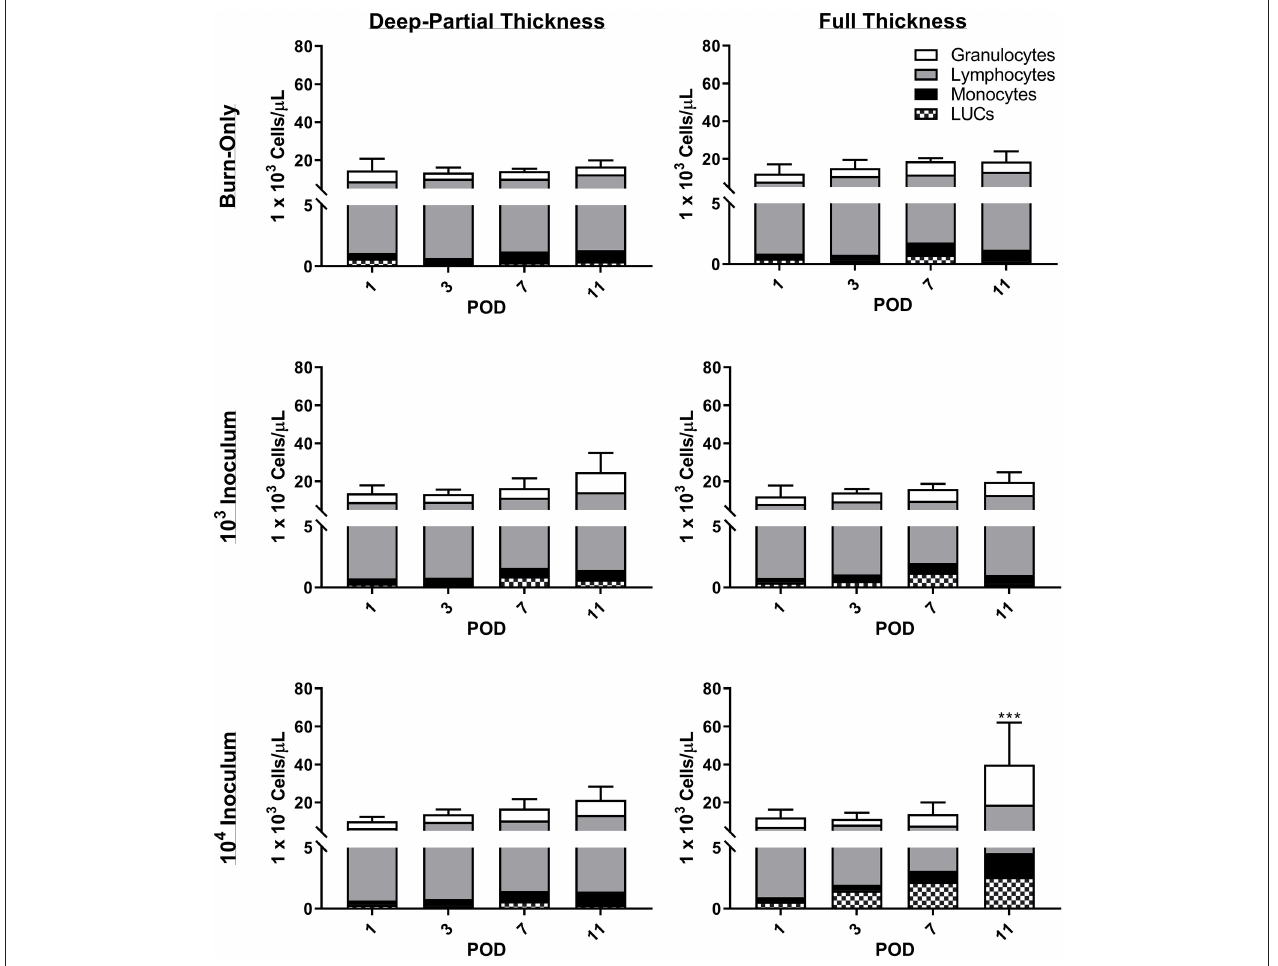
FIGURE 3 | Complete blood count analysis reveals increases in white blood cells following DPT & FT injuries. Increased WBC were noted to occur over time in all cases and were related to overall increases in granulocytes, lymphocytes, and monocytes. P. aeruginosa infection showed slightly elevated WBC counts over the burn-only group, becoming significant in the 10 4 CFU/wound group at POD 11 (*** p < 0.001 relative to FT burn-only) based on 2-Way ANOVA with Bonferroni multiple comparison post-test. Bars represent average WBC count with standard deviations. Unassigned cells are represented as large unidentified cells